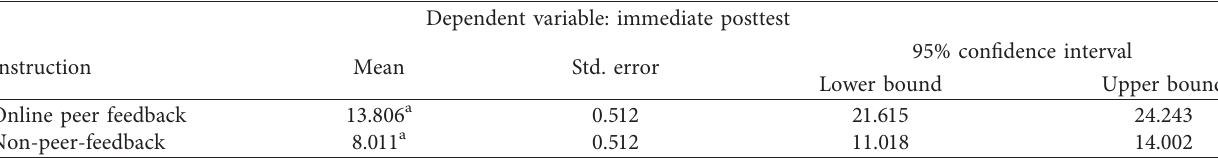
Table 4: Estimated marginal means.